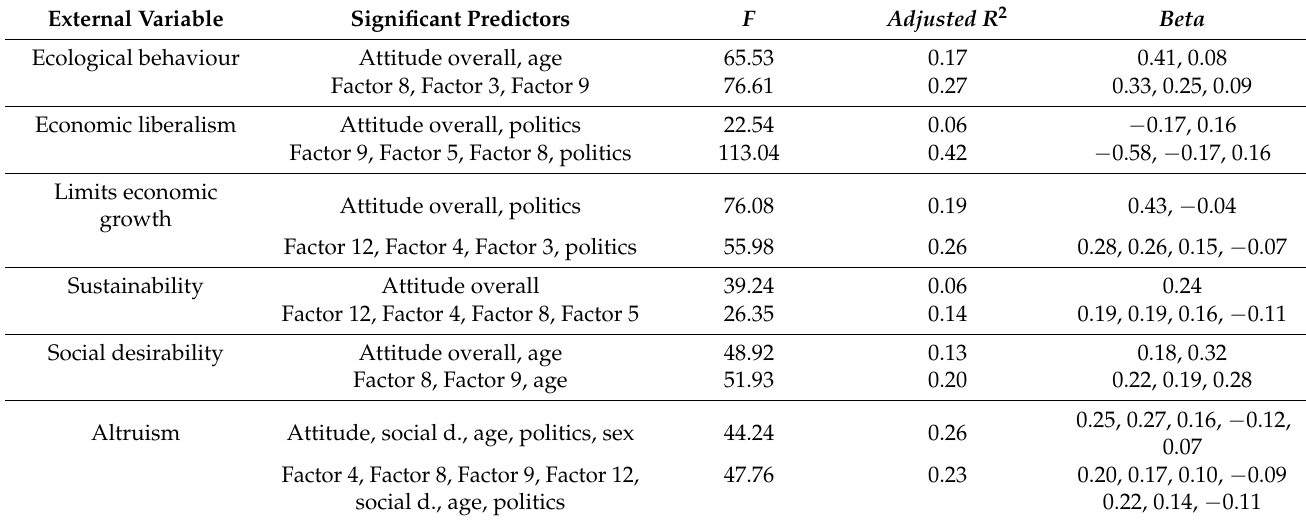
Table 4. Significant regression coefficients of external variables on attitudes in general population ( n =